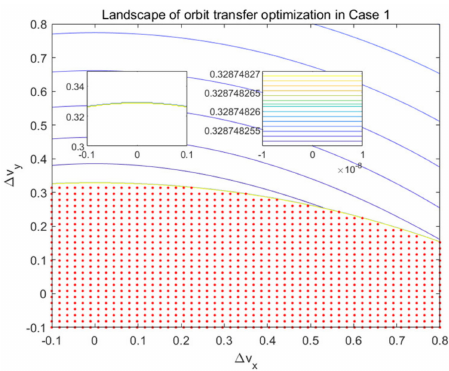
Figure 13. The landscape of orbit transfer in Case 1.